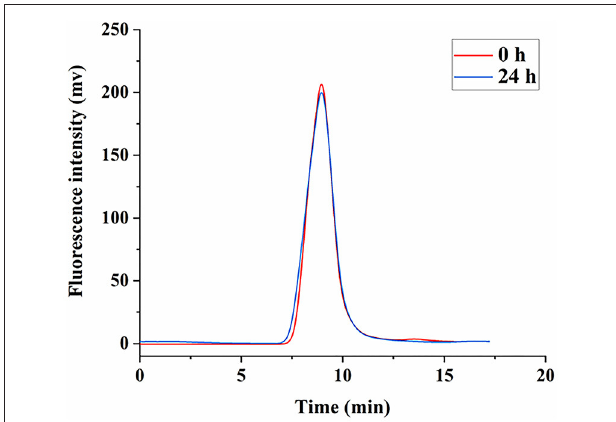
FIGURE 4 | Stability of FLNT incubation in phosphate-buffered saline (PBS) solution at 37 ◦ C.